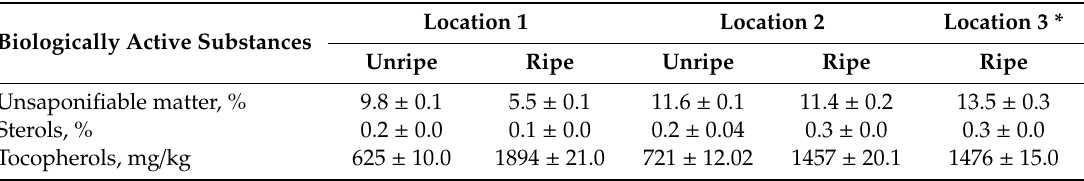
Table 3. Biologically active substances in the lipid fraction of J. excelsa unripe and ripe galbuli from the three collection sites in Bulgaria (mean ±